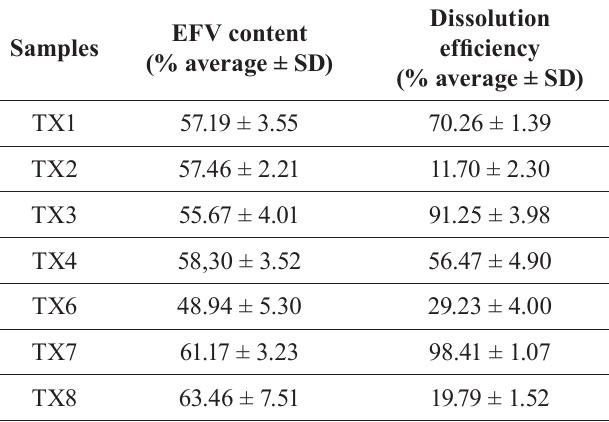
TABLE III - Drug concentration and dissolution efficiency of each sample in % with the respective standard deviation (SD)